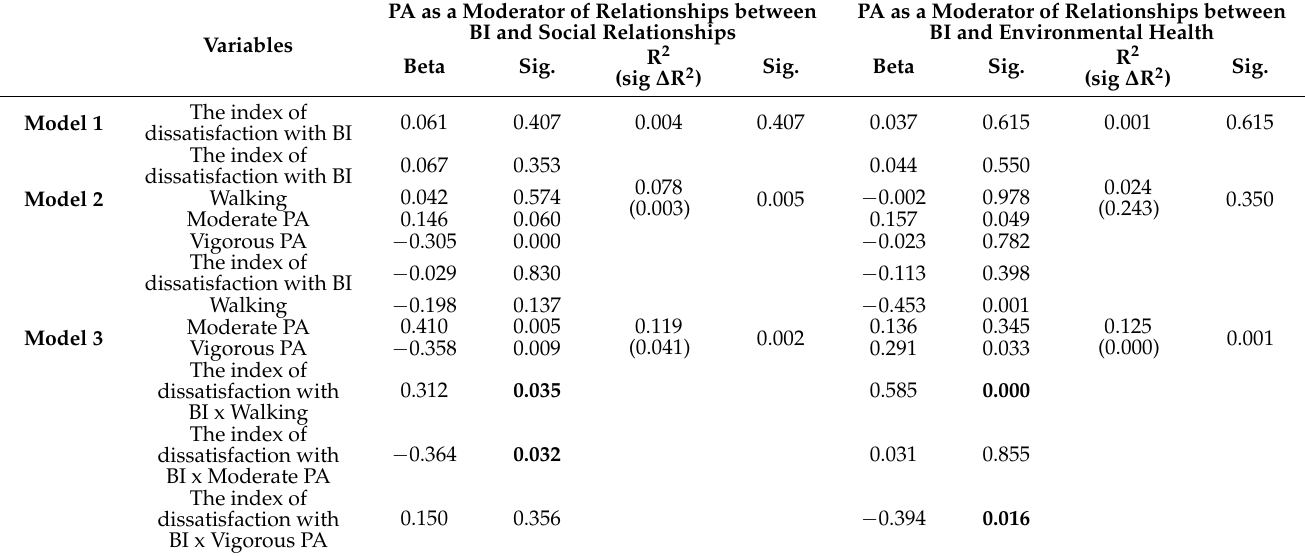
Table 4. Physical activity as a moderator of the relationships of BI with social relationships and environmental